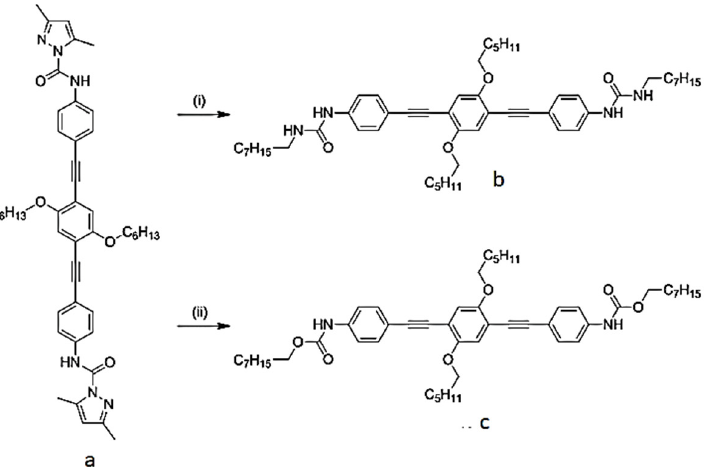
Figure 5. Schematic representation of the synthetic procedure of the model compounds ( a – c ). Reagents and conditions: (i) 1-Octylamine/ N , N ’-dimethylformamide/130 °C; (ii) 1-octanol/ N , N ’-dimethylformamide/130 °C. From reference [34].